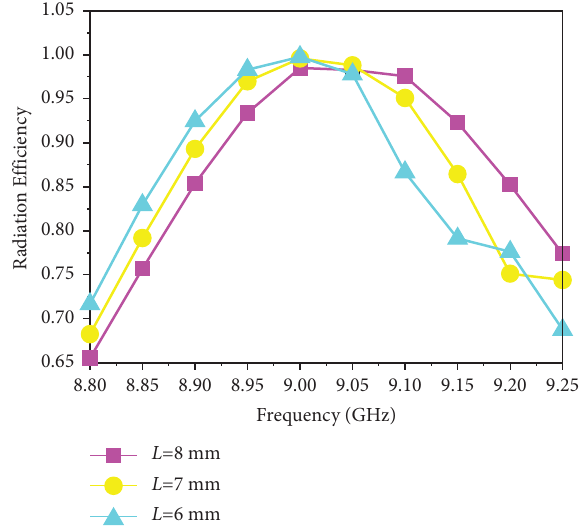
Figure 9: Radiation efciency comparison of the predicted antenna